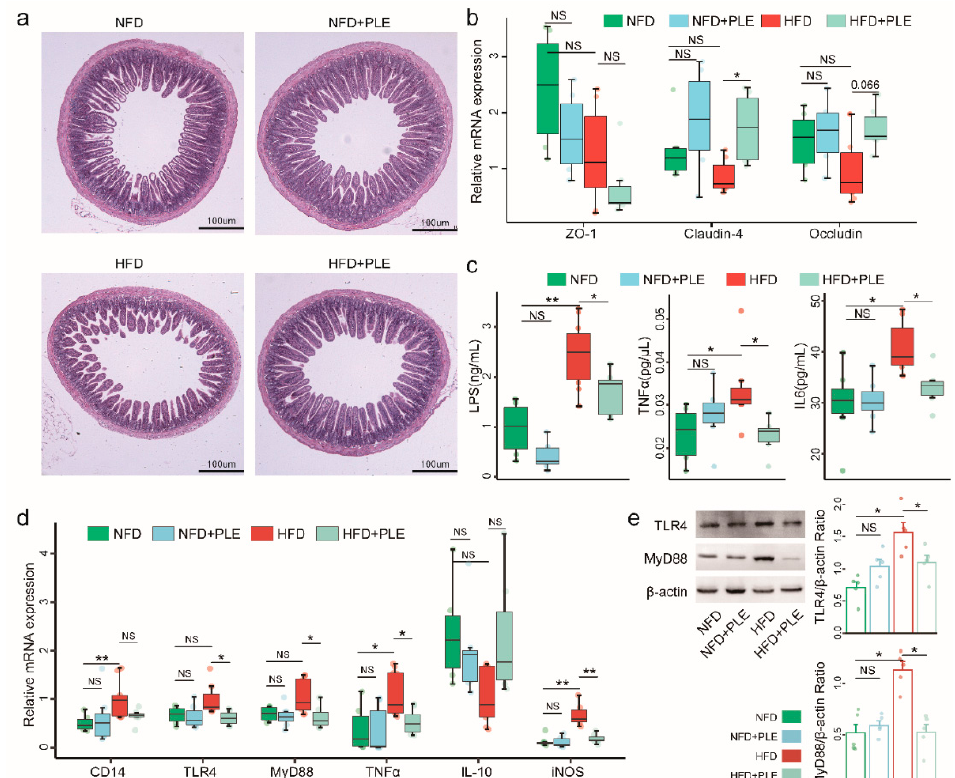
Figure 3. PLE alleviates intestinal barrier permeability and inhibits LPS-related TLR4-MyD88 signaling in the liver. ( a ) Representative H&E images of the terminal ileum in each group of mice (n = 7~9). ( b ) mRNA expression of ZO-1, claudin-4 and occludin in the ileum of each group of mice (n = 7~9). ( c ) Levels of serum LPS, TNF α and IL-6 in each group of mice (n = 7~9). ( d ) mRNA levels of the TLR4-MyD88 signaling pathway in the liver of each group of mice (n = 7~9). ( e ) Protein levels of TLR4 and MyD88 in the liver of each group of mice (n = 5). p values were calculated using the Wil-